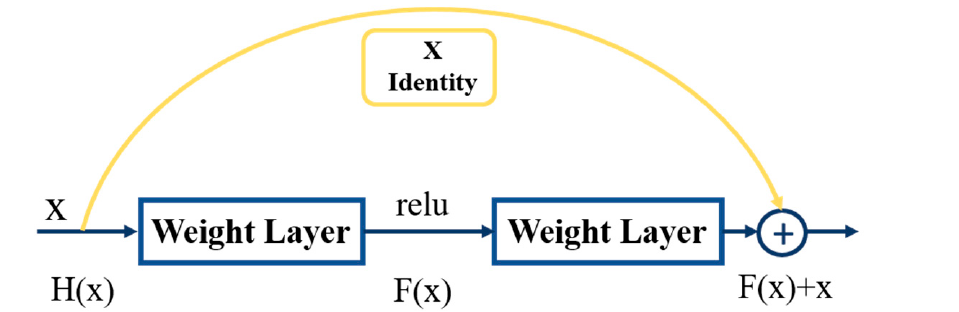
Figure 2. Designed model framework.